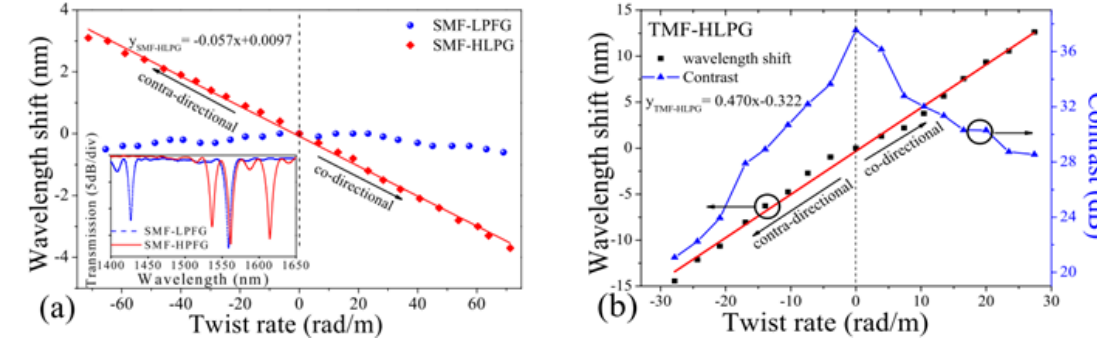
Figure 17. ( a ) Dependences of the resonance wavelengths (LPG and HLPG written in SMF) on the twist rate. (b) Dependence of the resonance wavelength on the twist rate of the TMF-HLPG. © [2021] IEEE. Reprinted, with permission, from Ref. [50].